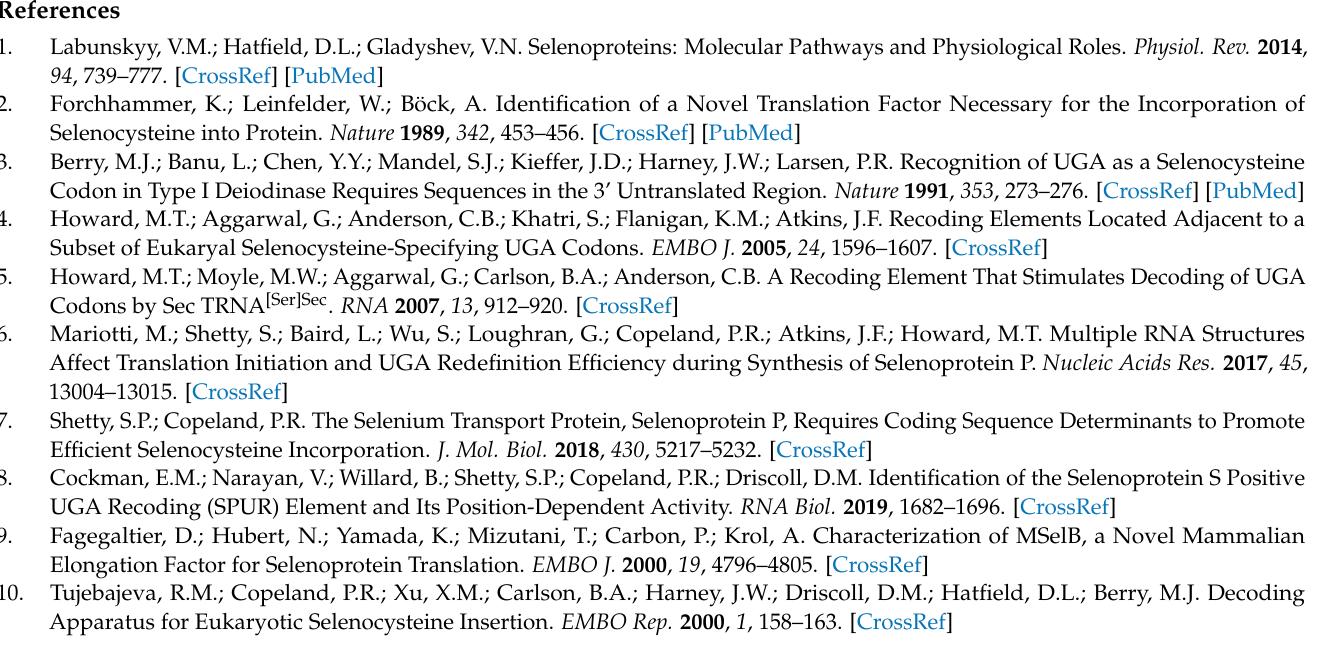
Figure A4. Frameshifting at the UGA/Sec codon in GPX1 occurs in HAP1 SECISBP2 -mutant cells. While the fraction of RPFs in frame 0 decreases 3 (cid:48) of the UGA/Sec, the fraction of frame +1 RPFs